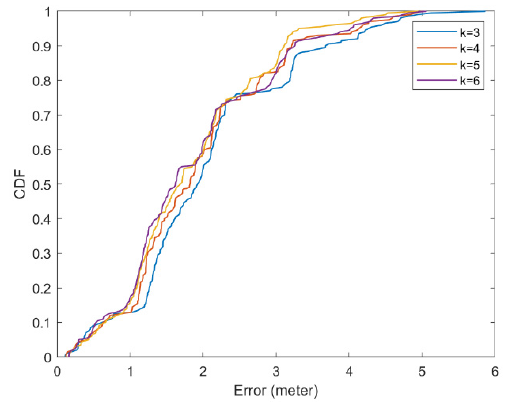
Figure 7. Positioning errors of different values of 𝑘 (CDF).